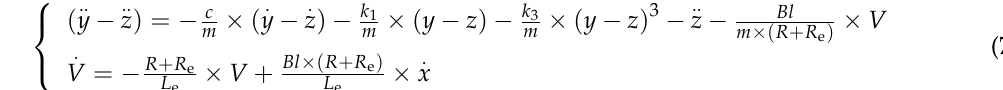
 z .. using the z using the